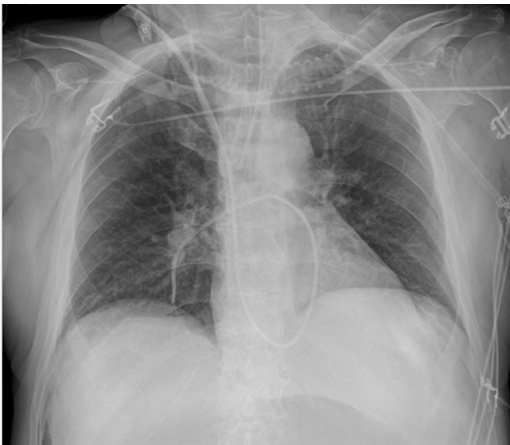
Figure 9. A Swan-Ganz catheter with the tip inside a right lower lobe pulmonary artery